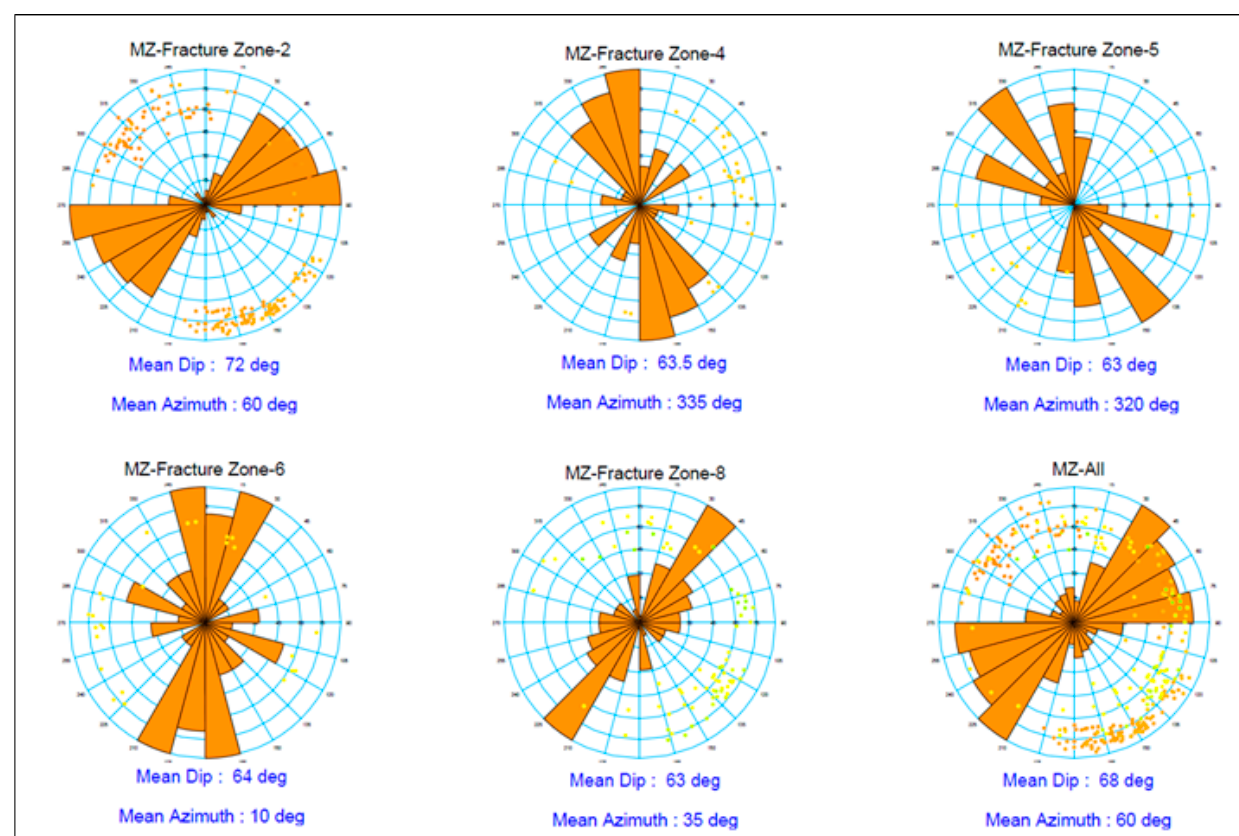
Figure 1. Rose diagrams showing di ff erent fracture sets.